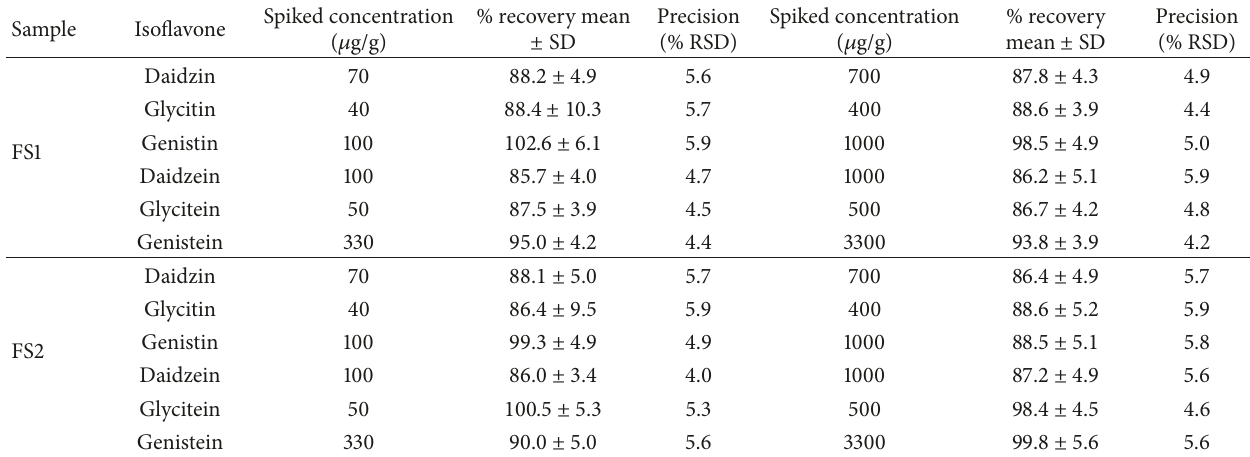
Table 2: Percentage recoveries of isoflavones obtained from two spiked soybean flours ( 𝑛 = 3 ) at different concentration levels, together with the within-day ( 𝑛 = 3 ) coefficients of variation. Sample